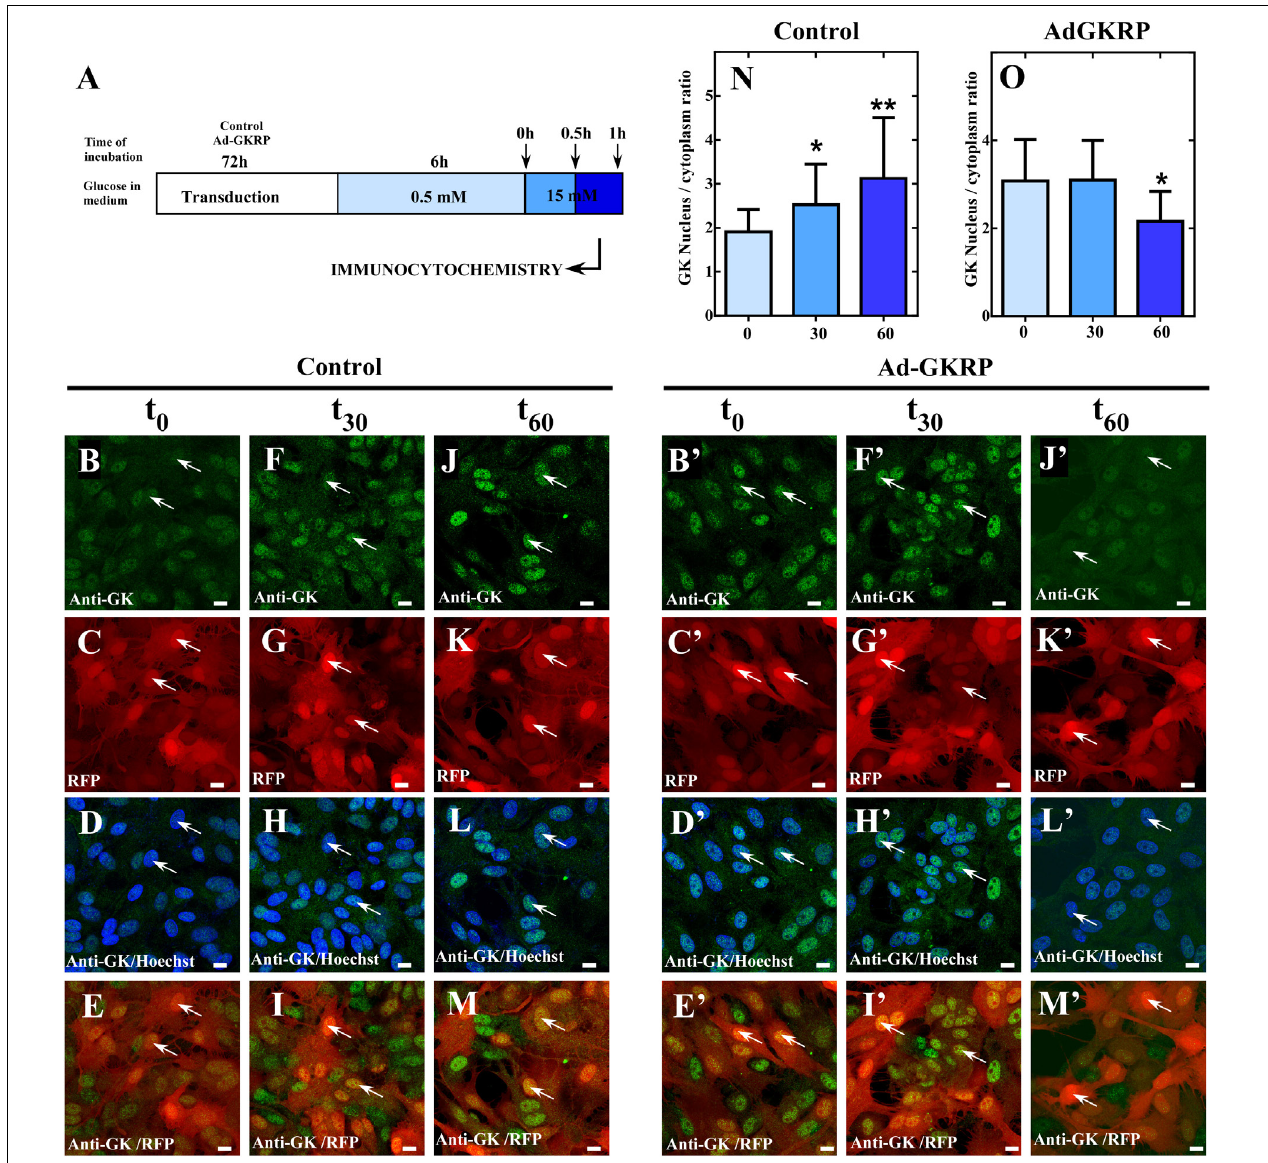
FIGURE 4 | Dynamic localization of GK in culture of tanycytes transduced with Ad-GKRP in response to high glucose. (A) Schematic representation of tanycytes transduction and glucose treatment. (B–M,B’–M’) Immunocytochemistry for GK in tanycytes transduced with Ad-control (B–M) and Ad-GKRP (B’–M’) incubated with 15 mM glucose for 0, 30, and 60 min. GK localization (green), Virus transduction (red), and nuclear staining with Hoechst. (N,O) Quantification of nuclear/cytoplasmatic ratio of GK fluorescence intensity for Ad-Control (N) and Ad-GKRP (O) . Statistical T -test, ∗ p -value < 0.05, ∗∗ p -value < 0.01. White arrows are indicating the nucleus of